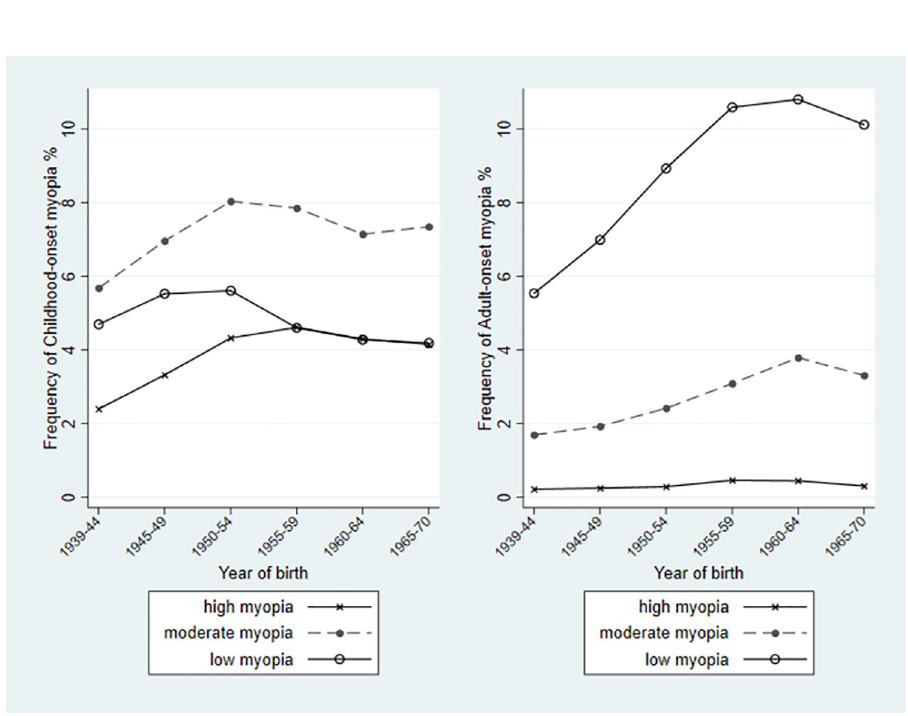
Fig 3. Frequency of childhood-onset and adult-onset myopia by severity (high, moderate and low), by year of birth as 5-year bands.